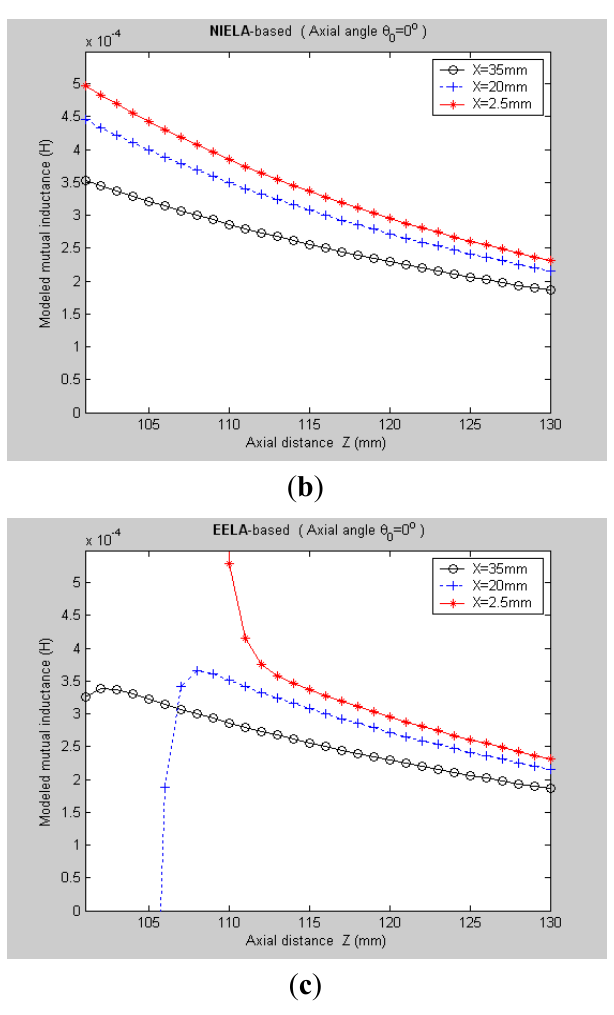
Figure 10. 2-D graphs of ( a ) measured mutual inductance voltage; ( b ) NIELA -based mutual inductance; ( c ) EELA -based mutual inductance versus axial distance Z ( θ Z = 101–130